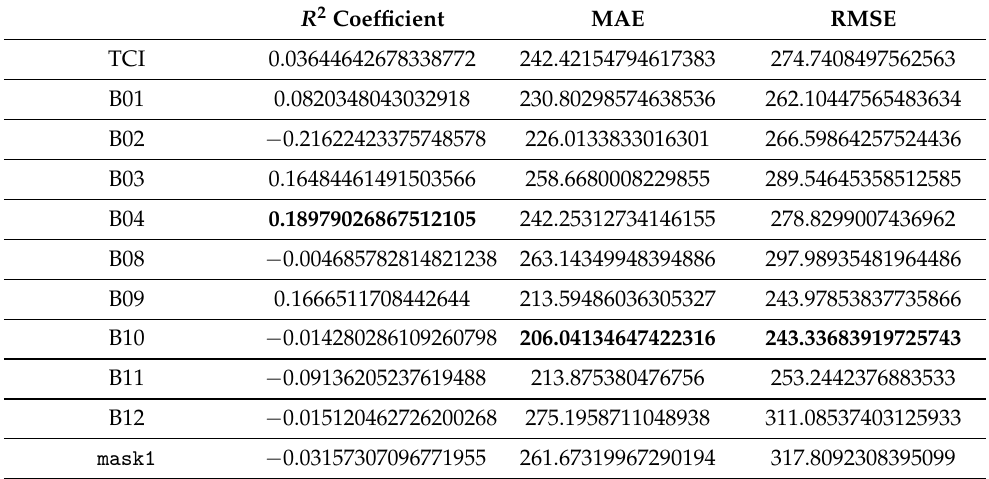
Table 4. R 2 Coefficient, MAE, and RMSE for predicting GI. Best scores are highlighted in bold.